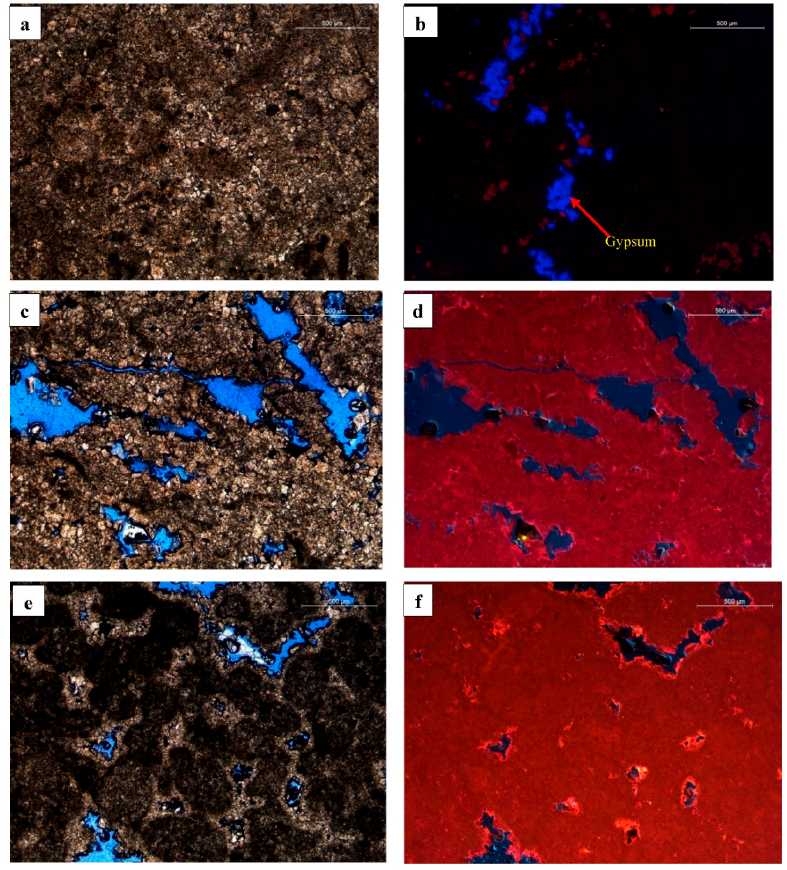
Figure 3. Cathodoluminescence micrograph of the Leikoupo Formation dolomites. ( a , b ) Well Yas1, 5738.8 m, dolomicrite, dull luminescence; ( c , d ) Well Ys1, 6196.27 m, algal framework dolomite, bright red luminescence; and ( e , f ) Well Ys1, 6223.63 m, dolomite with precursor carbonate grain textures, bright red luminescence.